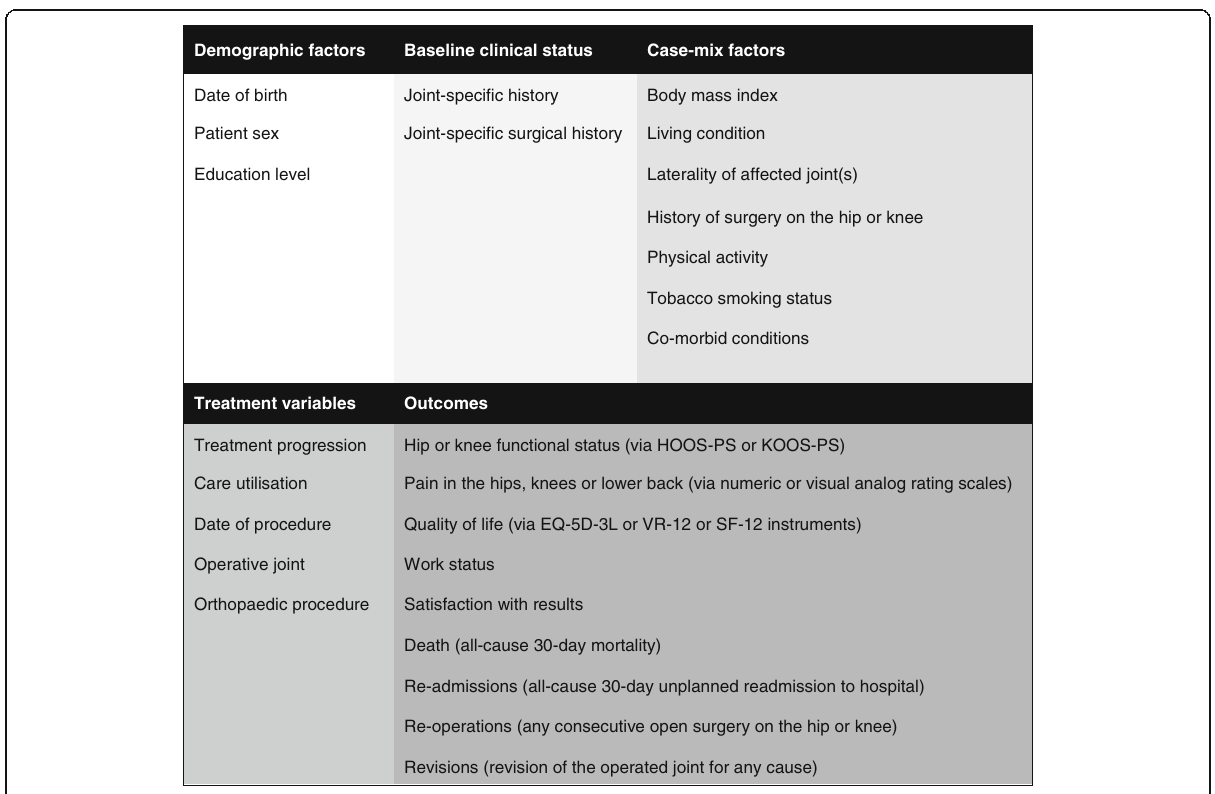
Fig. 1 Overview of ICHOM Standard Set for Hip and Knee Osteoarthritis variables EQ-5D-3L: EuroQoL 5-dimension health-related quality of life instrument (3 response level version); HOOS-PS: Hip Disability and Osteoarthritis Outcome Score - Physical function short form; KOOS-PS: Knee Injury and Osteoarthritis Outcome Score - Physical function short form; SF-12: Short Form 12 Health Survey; VR-12: Veterans RAND 12